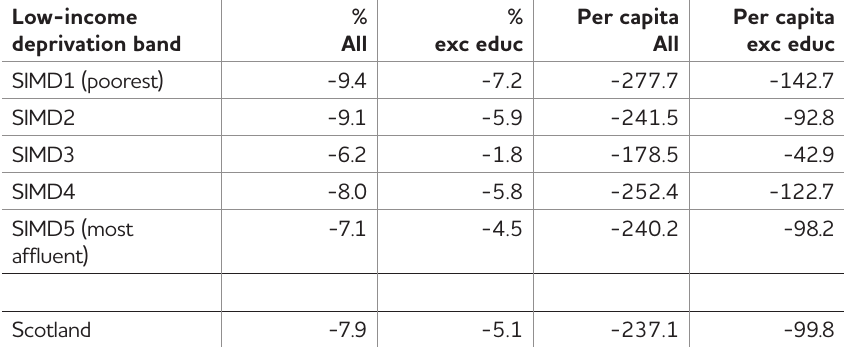
Table 2: Real budget spending change by deprivation band, Scottish local authorities,